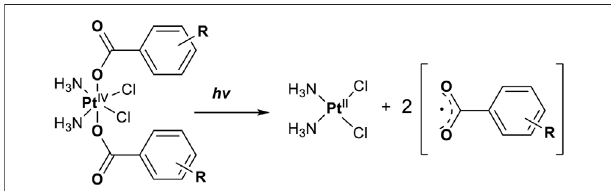
FIGURE 4 | Schematic representation of photolysis of complexes 50 , 56 , and 57 [adapted from Lee et al. (2019)].